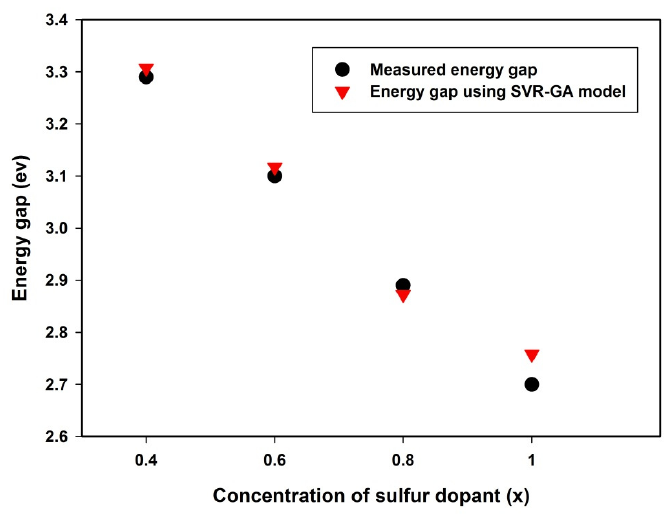
Figure 5. Influence of sulfur particles on energy gap of ZnS 1-x Se x.